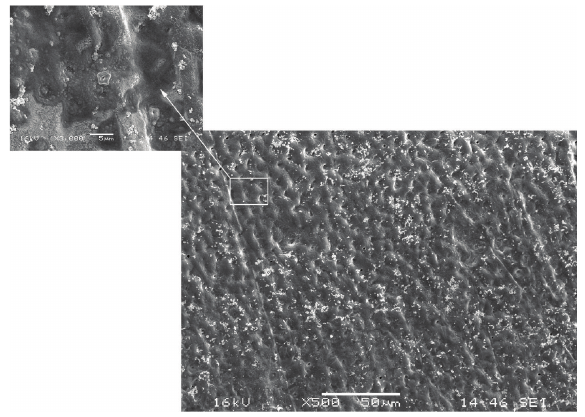
Figure 2: SEM ( × 1500, × 3000) showing dentin surface in air abrasion group.